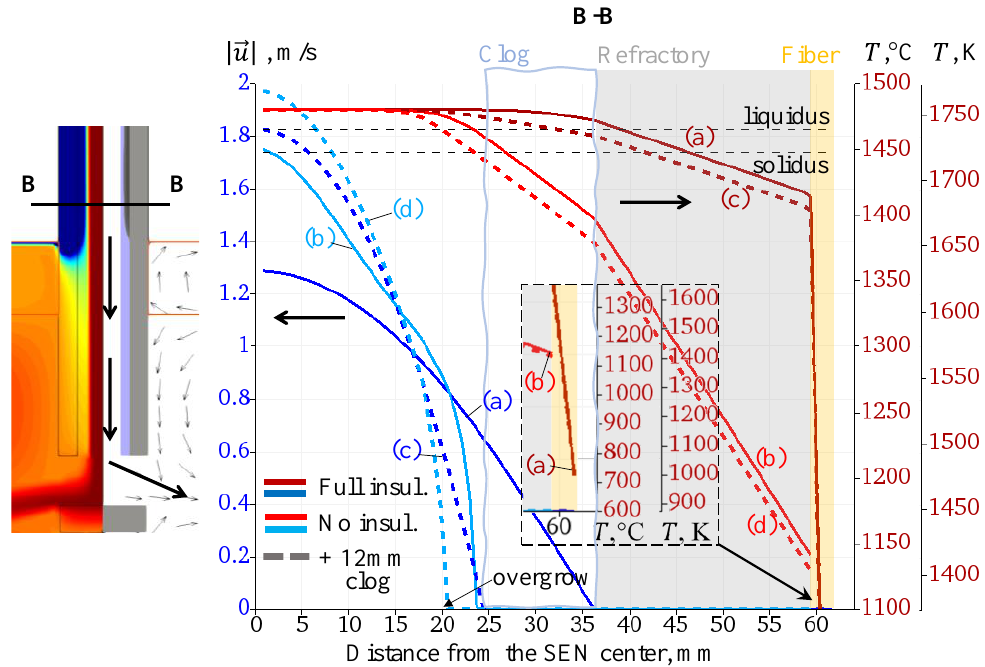
Figure 11. Velocity magnitude profile and the temperature distribution along the B-B line 50 mm above the slag layer for the cases ( a , b ) of a fully and uninsulated SEN without clogging (solid lines) and ( c , d ) considering a uniform 12 mm clog layer (dashed lines); the SEN outer surface temperatures are shown in a zoomed view.